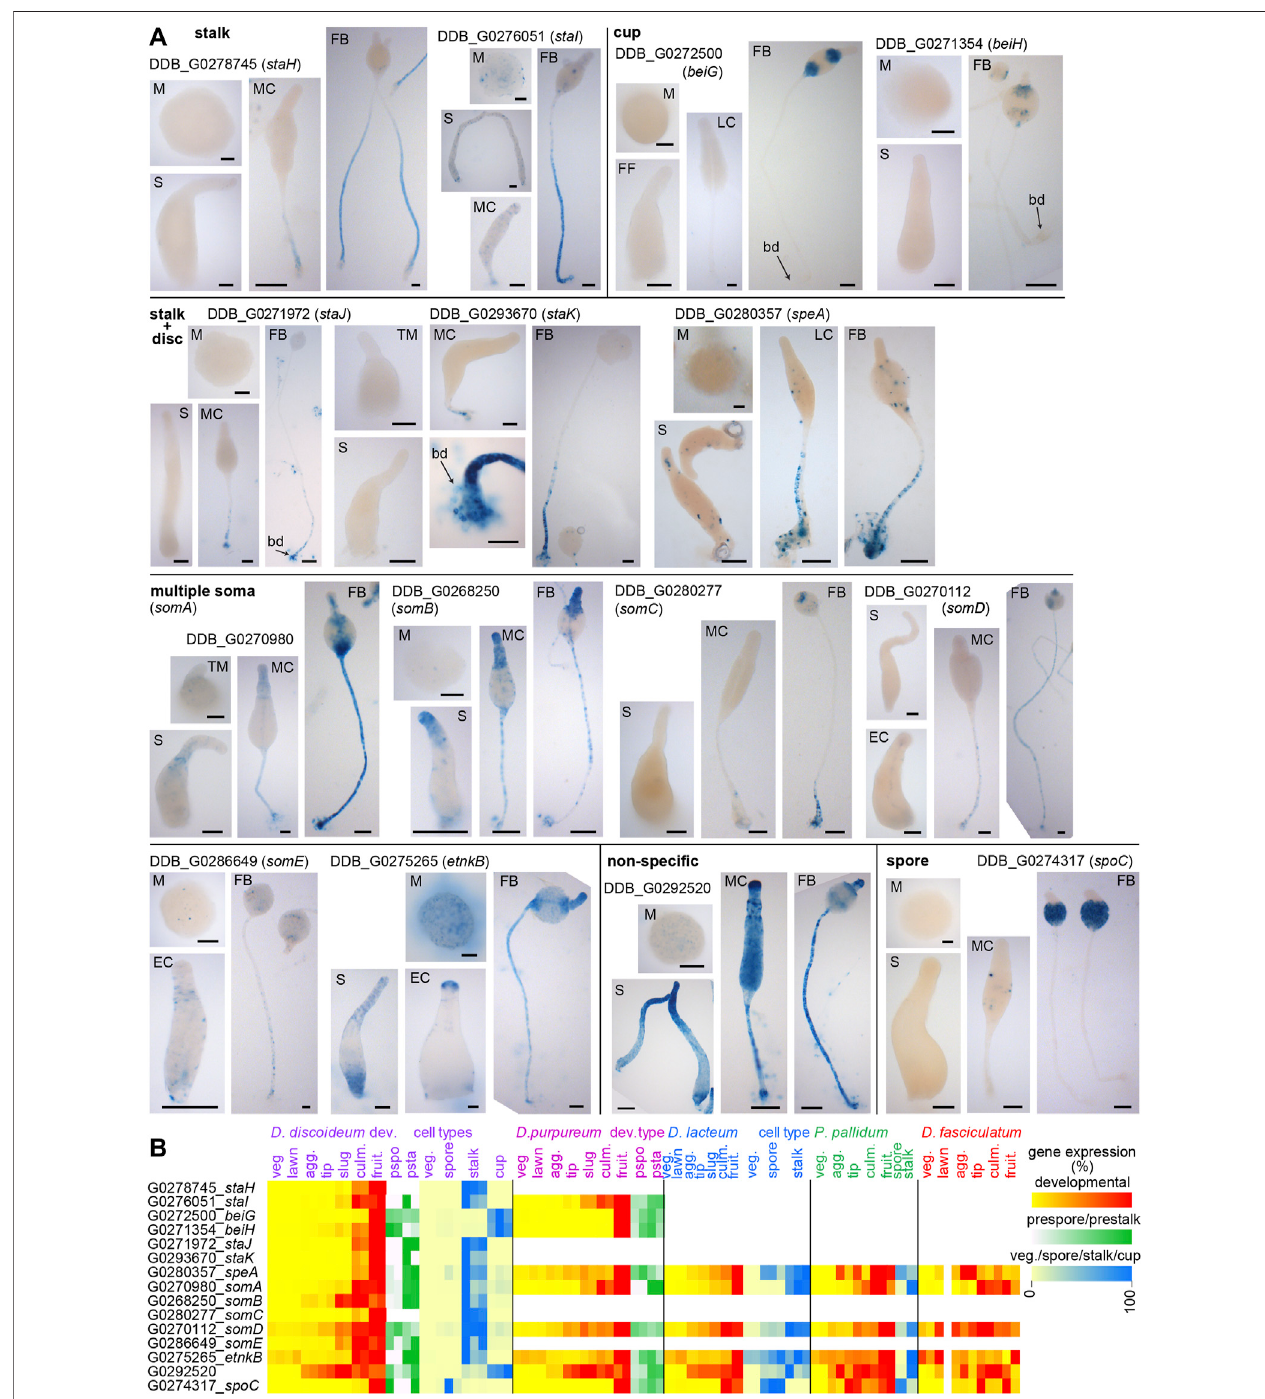
FIGURE1| Expressionpatternsofputativecelltypespeci fi cgenes. (A) .Spatialpatterns.Ddis AX2cellsweretransformedwithfusionconstructsof LacZ andthe5 ′ intergenic regions of putative cell-type speci fi c genes identi fi ed from cell-type speci fi c RNAseq (Kin et al., 2018). Cells were starved at 10 6 cells/cm 2 on nitrocellulose fi lters supported by non-nutrient agar to induce multicellular development. Structures were fi xed and incubated with X-gal to visualize β -galactosidase activity at the mound (M), fi rst fi nger (FF),slug(S), culminant (EC: early culminant, MC: mid-culminant, LC: late culminant) and mature fruiting body (FB) stages. Per transformant, theincubationperiodwasthesameforallstages.Bars:50 µm. (B) . Transcriptomes .RNAseqdatafortheinvestigatedgeneswereobtainedfrompublishedexperiments ofdevelopmentaltimecoursesandpuri fi edcelltypesacrosstaxongrouprepresentativespecies(Parikhetal.,2010;Heideletal.,2011;Gloeckneretal.,2016)(Kinetal., 2018). Normalized read counts are standardized to maximum or summed (prestalk/prespore) read counts per series and shown as heatmaps of two or three replicate experiments (veg: feeding cells, lawn: starving cells, agg: aggregate, tip: tipped mound, culm. culminant, fruit. fruiting body, pspo. prespore, psta. prestalk).